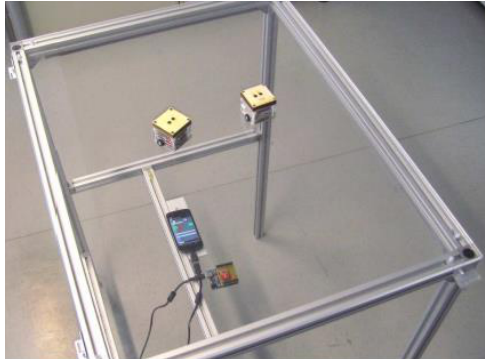
rotation for controlling a music player, a module for measuring physical properties (light intensity, etc.), and an alternative motor module. From the initial evaluation, the system is suitable as a prototyping platform for TUI research. The system is also suitable for educational purposes to teach TUI concepts [71].